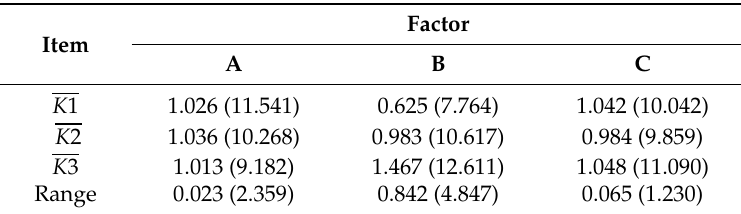
Table 3. The results of direct analysis and range analysis for Sa and Sz.